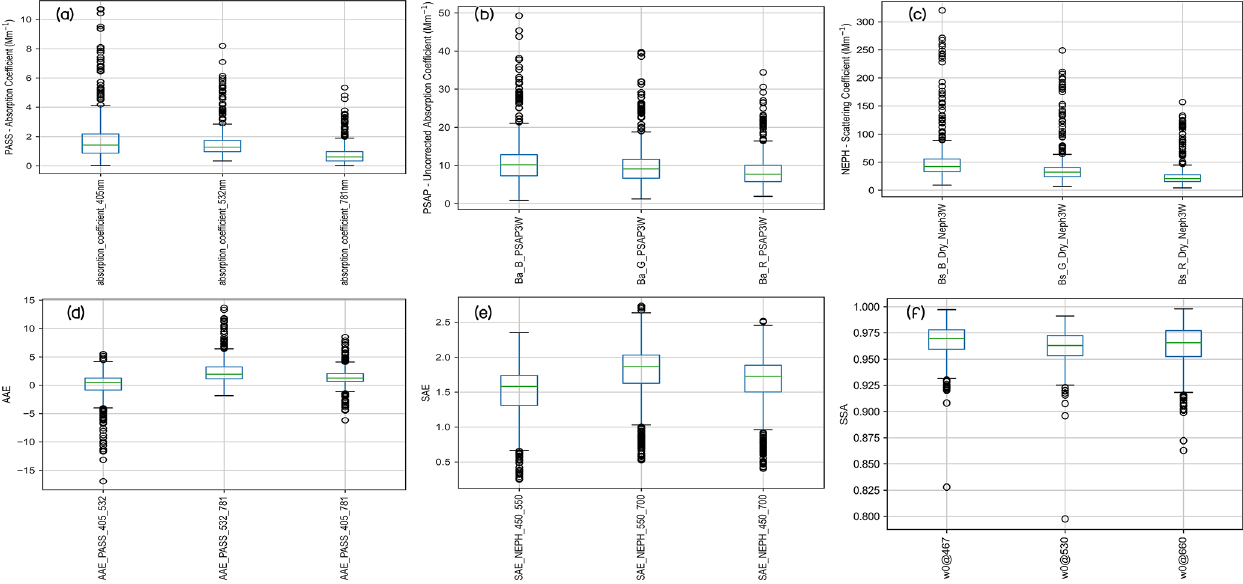
Figure A1. Summary of the SGP dataset. The boxplots of raw measurement data are shown as obtained from various instruments used in this study: (a) PASS, (b) PSAP { B abs_uncorrected_PSAP } , and (c) nephelometer. The boxplots of parameters derived from the raw data are also shown: (d) AAE, (e) SAE, and (f) SSA. The green line is the median of the data. The bottom line of the box is the 25th percentile of the data, and the top line of the box is the 75th percentile of the data. Therefore, the box represents the middle 50% of all the data points, which is the core of the data.